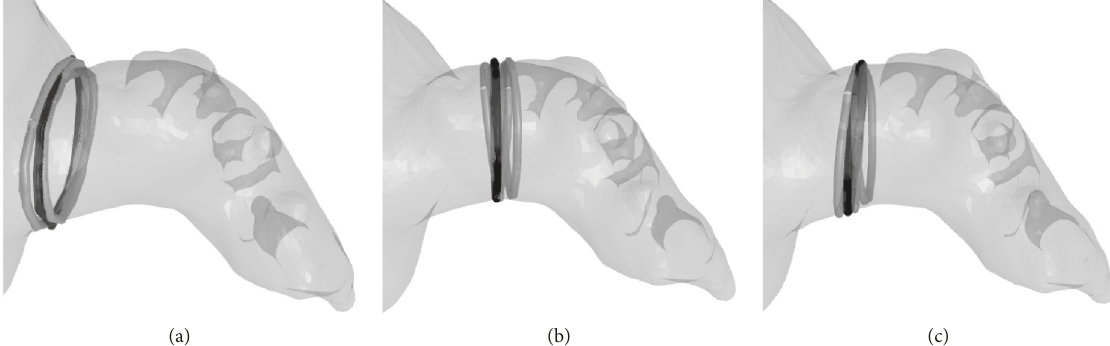
Figure 6: Example of the ostium and landing zone curves in the detected planes for 1 patient. The black curve shows the predicted curve, while the curves from the three different observers are shown in gray. (a) Anatomical ostium plane. (b) Landing zone plane (Amulet). (c) Landing zone plane (Watchman FLX).